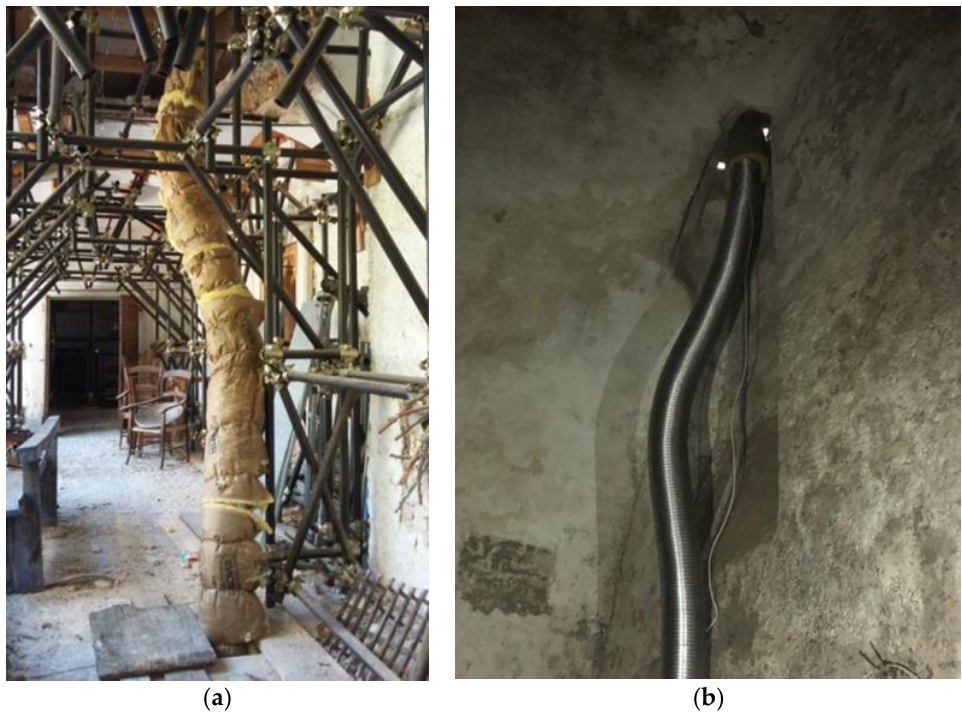
Figure 3. The duct once installed ( a ) in the cellar; ( b ) on the ground floor under the arcade.